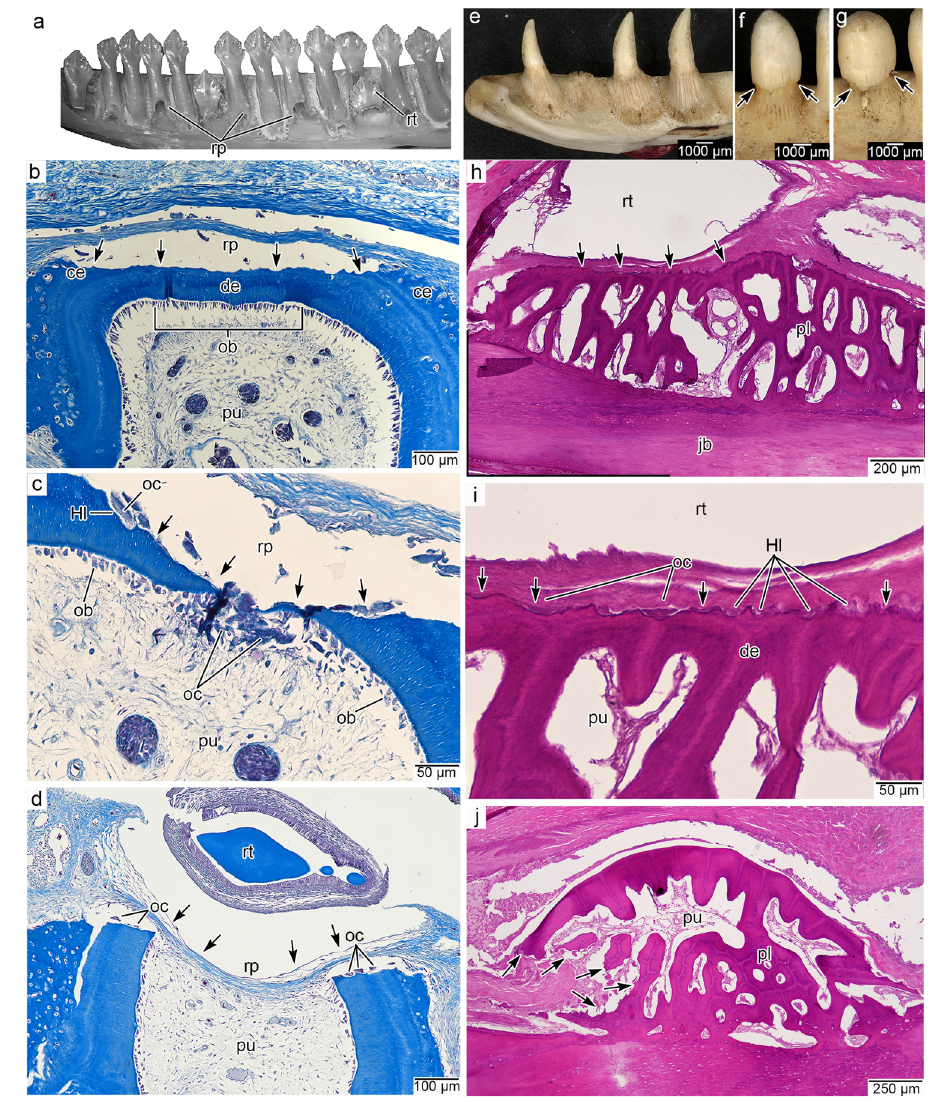
Fig. 5 | Iguanid- and varanid-type tooth resorption in Iguana and Varanus . a Lingual view of a dentary of Iguana delicatissima (MCZ 10975) exhibiting